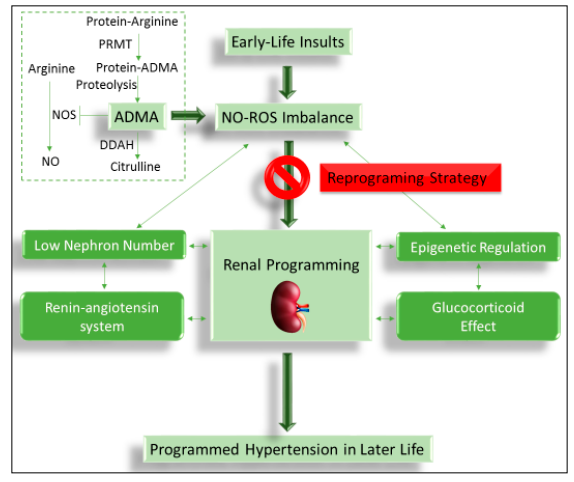
Figure 1. Schema outlining the central role of NO-ROS imbalance on mediating other mechanisms in the kidney, leading to programmed hypertension in response to early-life insults. Targeting the ADMA-related NO-ROS imbalance could be a therapeutic option to prevent the development of programmed hypertension to reduce the lifetime burden with early intervention.